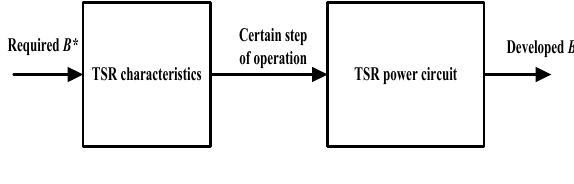
Fig. 5. Flow chart for controlling thyristors switched reactors